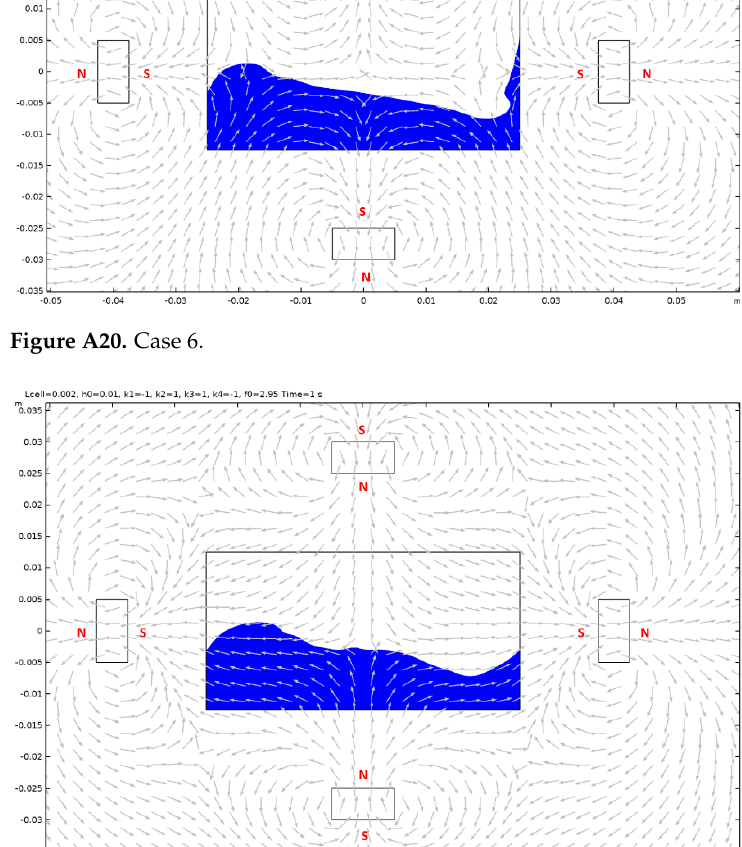
Figure A21. Case 7. Figure A21. Case